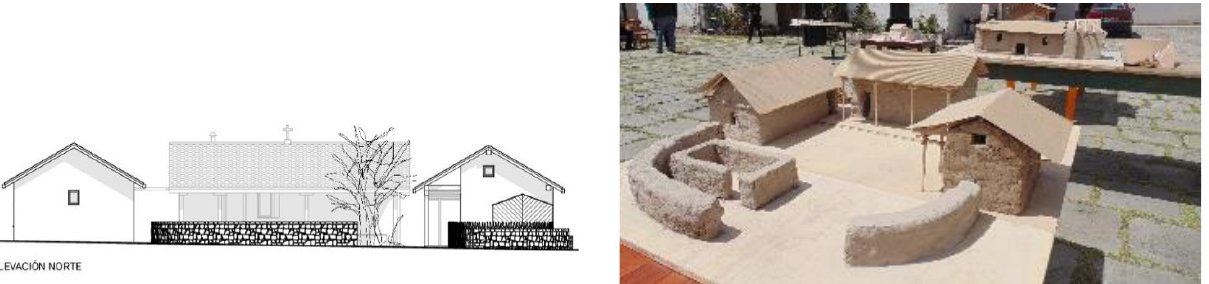
Figure 6. c) House designed for the agricultural area. Source: Photographic Repository of the Ciudad Patrimonio Mundial